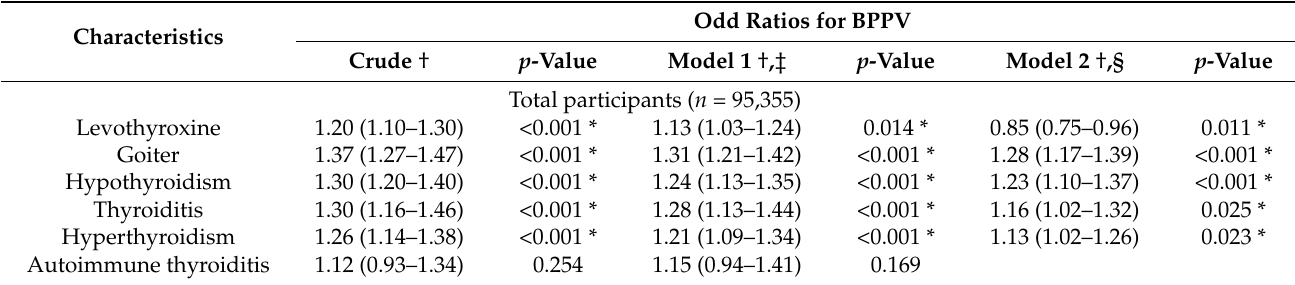
Table 2. Crude and adjusted odd ratios (95% confidence interval) for BPPV in levothyroxine, goiter, hypothyroidism, thyroiditis, hyperthyroidism, and autoimmune